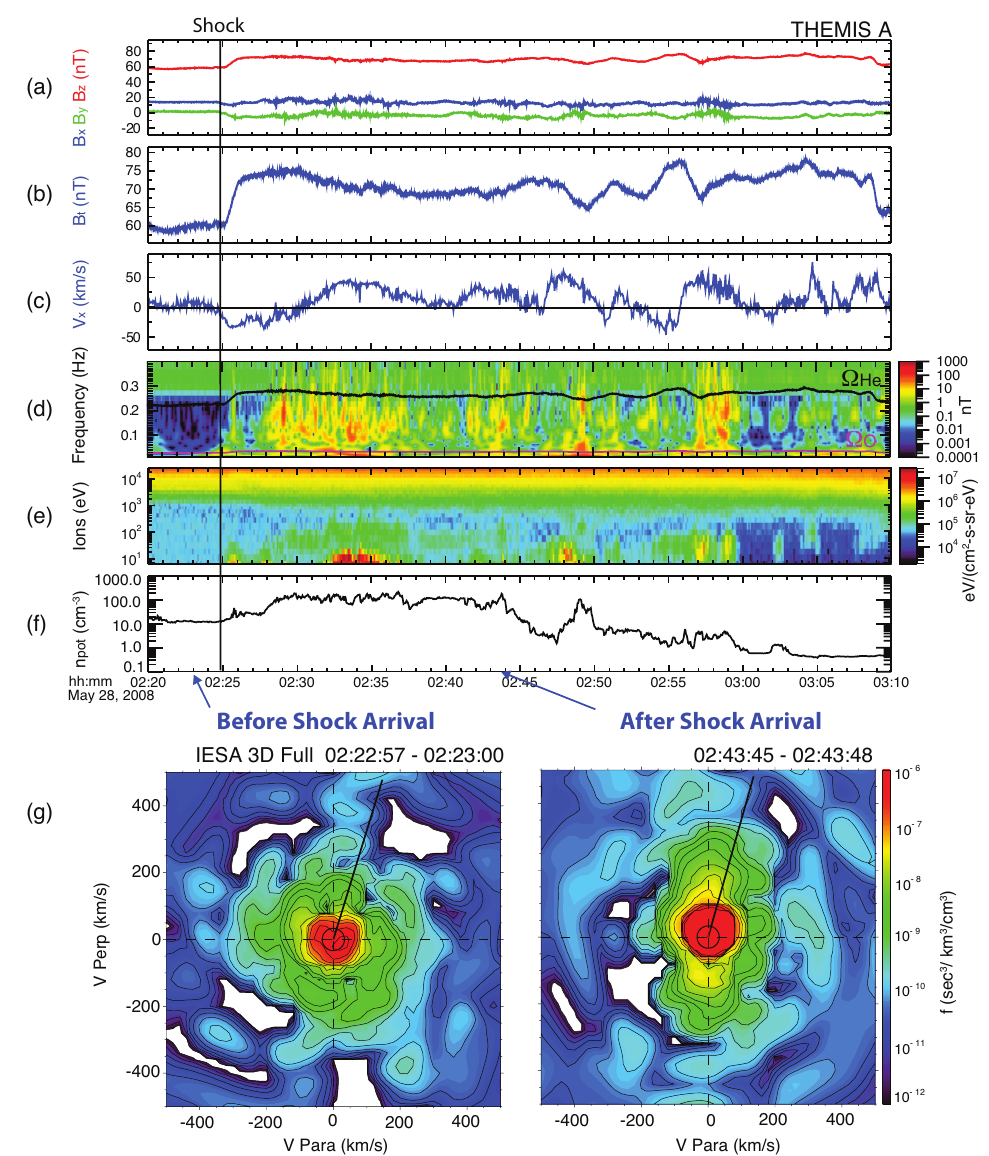
Fig. 4. THEMIS A (in the magnetosphere) observations of the EMIC wave activity and plasmaspheric plumes. From top to bottom: (a) three components of the magnetic field in GSM coordinates, (b) the magnetic field strength, (c) the x-component of the plasma flow velocity in GSM coordinates, (d) wavelet analysis result for the B y component of the magnetic field, (e) ESA ion spectrum, (f) plasma density derived from the spacecraft potential and electron thermal speed measured by the EFI and ESA instruments, respectively, and (g) ion distributions for 3s time intervals before (left) and after (right) the shock arrival. The thick black lines point toward the Sun. anisotropic (with T ⊥ /T k > 1) at energies above 50 eV (or the IP shock impact. One may wonder whether this event is V > 100 km s − 1 ) after the shock passage. The displacement typical or not. The magnetic field strength compression ratio towards positive V perp in the right panel is evidence for ac- of this IP shock is 2 (calculated from the magnetic field mea- celerated flows. The strong anisotropy appeared at around surement across the shock as shown in Fig. 1f) which is close to the average compression ratio of IP shocks for both so- 02:28:30 UT. The anisotropy A i is ∼ 1 at 02:43:45 UT, and the EMIC wave frequency should be less than 0.5 Hz which lar maximum (1.97) and solar minimum (1.93) (Echer et al., is consistent with the wave frequency shown in panel (d) 2004), therefore, this event is of Fig. 4. Therefore, the observed EMIC waves were most likely excited by the anisotropic ion distributions caused by